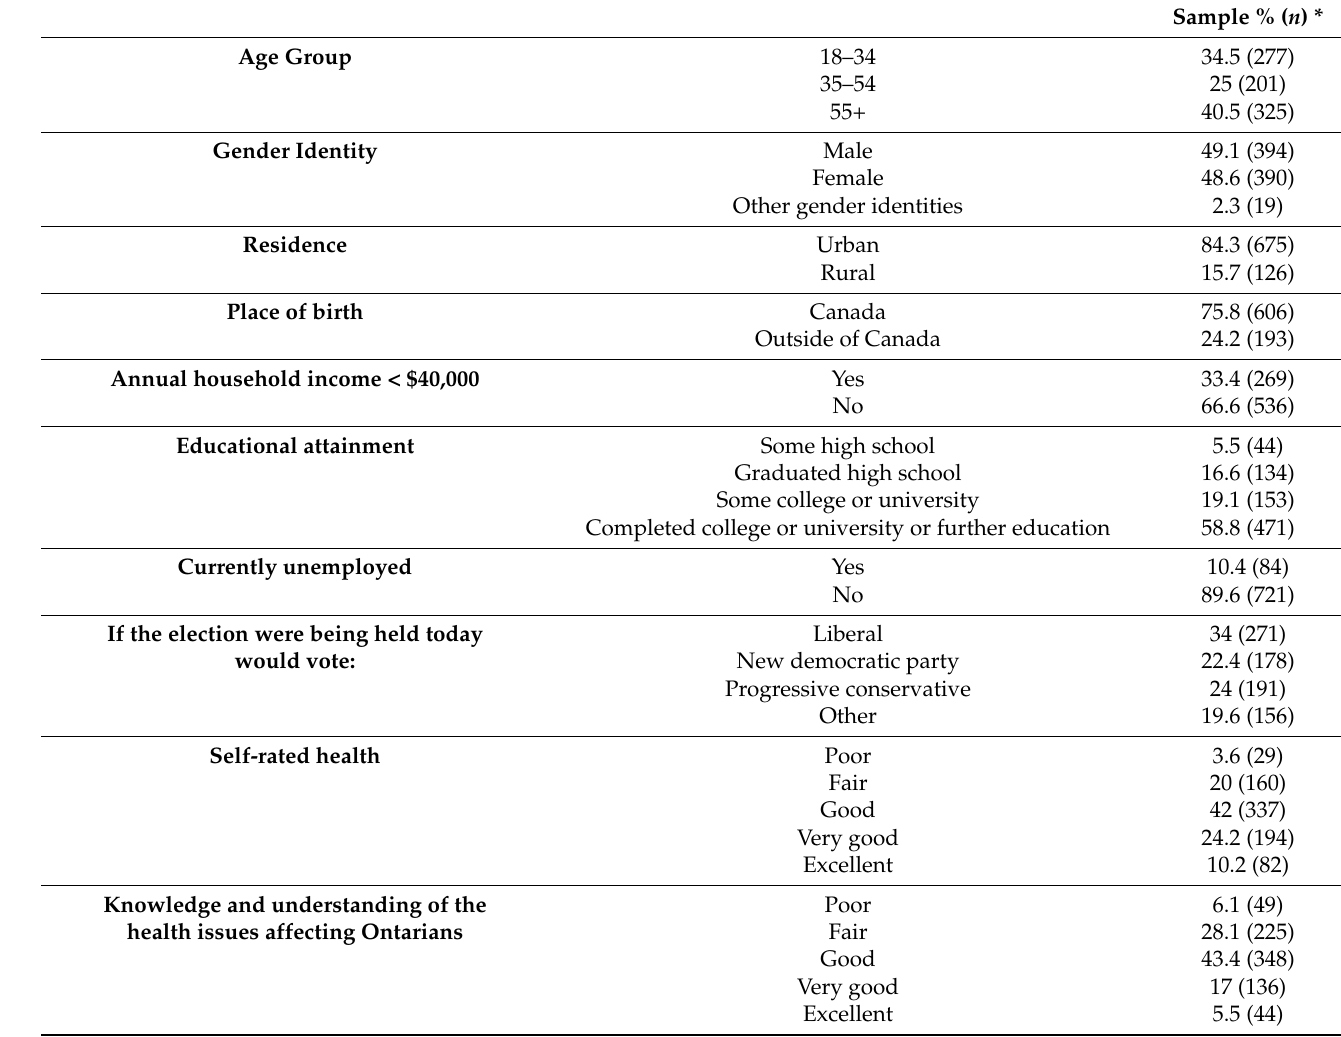
Table 2. Descriptive characteristics of sample ( n = 805).